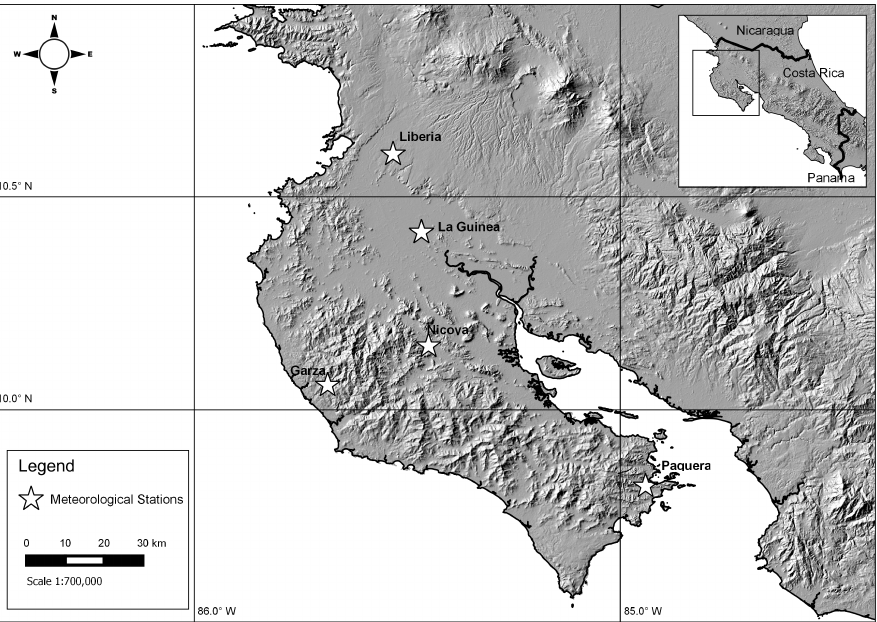
Figure 1. Location map of the Futuragua study domain showing topography and the five meteorolog- ical